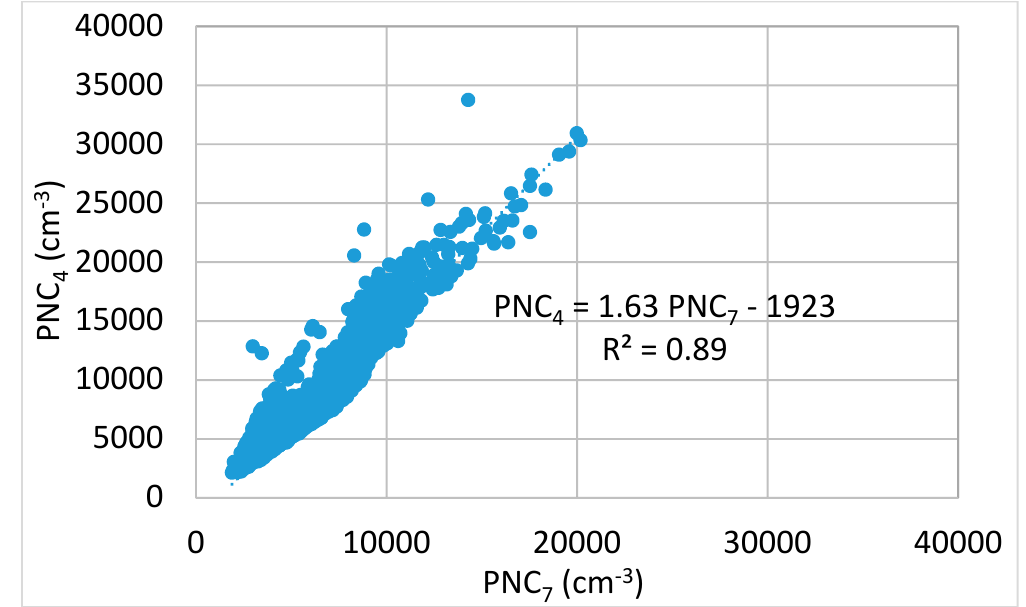
Figure A2. Correlation between PNC 4 and PNC 7 at an urban background site (Torkel Knutssonsgatan) in central Stockholm. The mean value of the measured concentrations of PNC 4 is 8650 cm − 3 , with a root mean square error (RMSE) of 1355 cm − 3 in relation to the modeled PNC 4 values, based on the linear regression with PNC 7 .